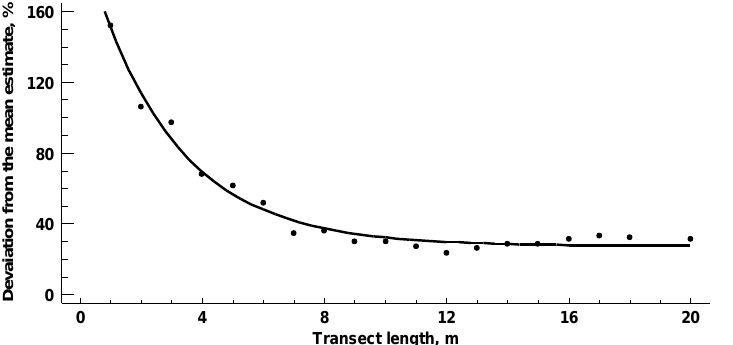
Figure 5. Improvements in precision of the mean (percentage of deviation from the mean estimate) with transect length (m) for pieces between 4 and 7 cm in diameter, based on 25 transects per site (observed data in the Forest Stands, black dots; adjusted model, black line).